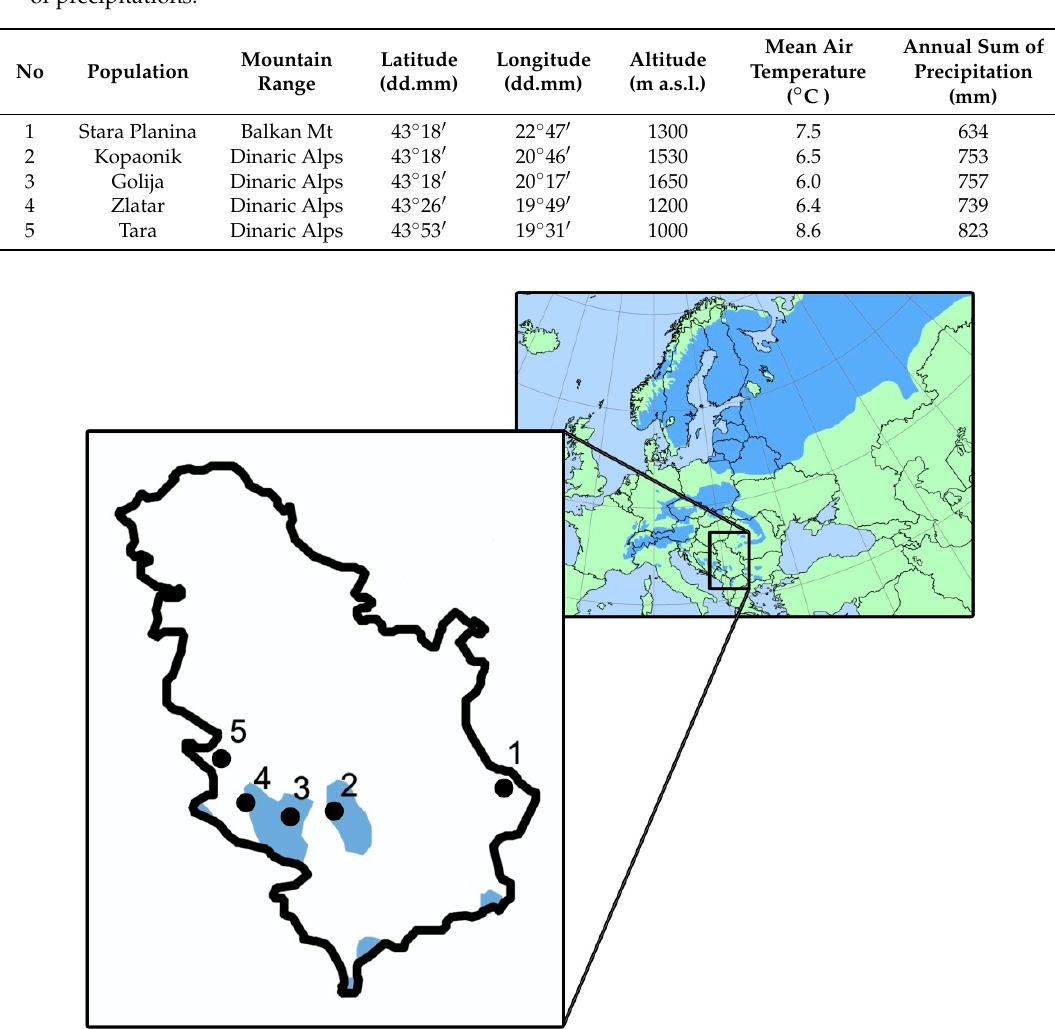
Figure 1. Geographical locations of Norway spruce populations in the study. The numbers indicate populations as presented in Table 1. The blue area represents the natural distribution range of Norway spruce (after: Skrøppa [22]). Table 1. Population names, geographic coordinates, altitude, mean air temperature, and annual sum of precipitations.